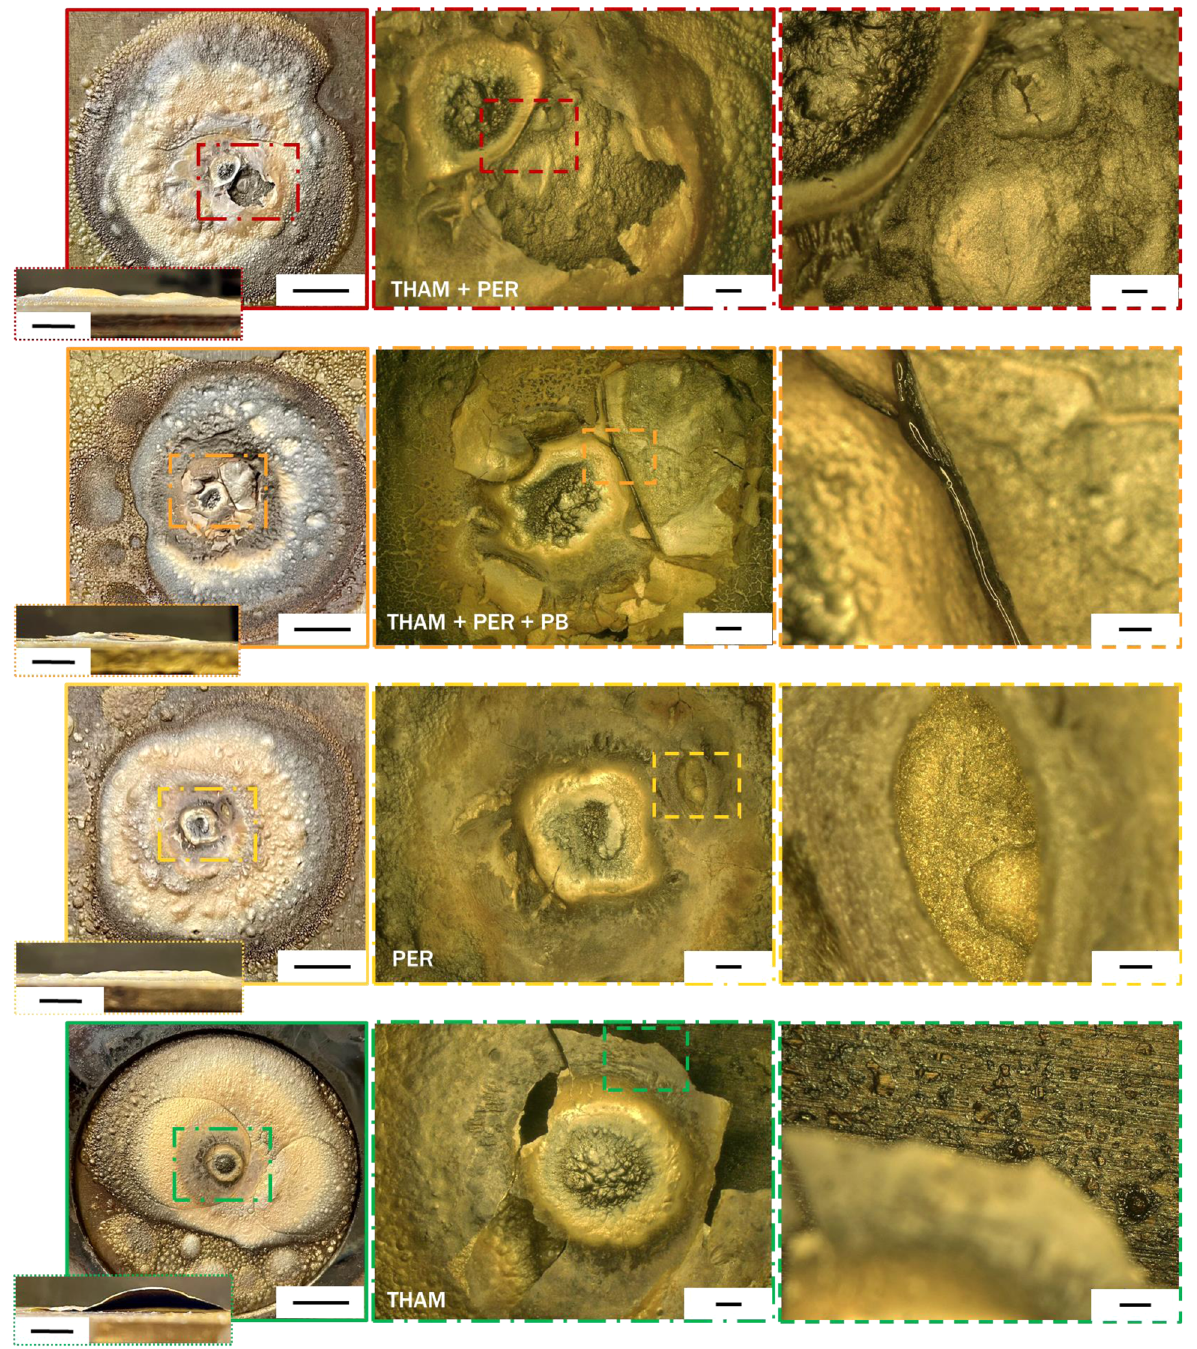
Fig. 6 Digital and optical imaging. Digital and optical images of 14 BL fi lms with THAM + PER (red), THAM + PER + PB (orange), PER (yellow), or THAM (green) after torch testing and corresponding cross-sectional image of each. Across each row, each image is progressively zoomed in views of the bubble architecture. Scale bars for cross-sectional images and macroscale bubble images (on the left) are 1 cm. Scale bars for middle images are 1 mm. For far right images the scale bars are as follows: 300 µm for THAM + PER (red), 250 µm for THAM + PER + PB (orange), 250 µm for PER (yellow), and 500 µm for THAM